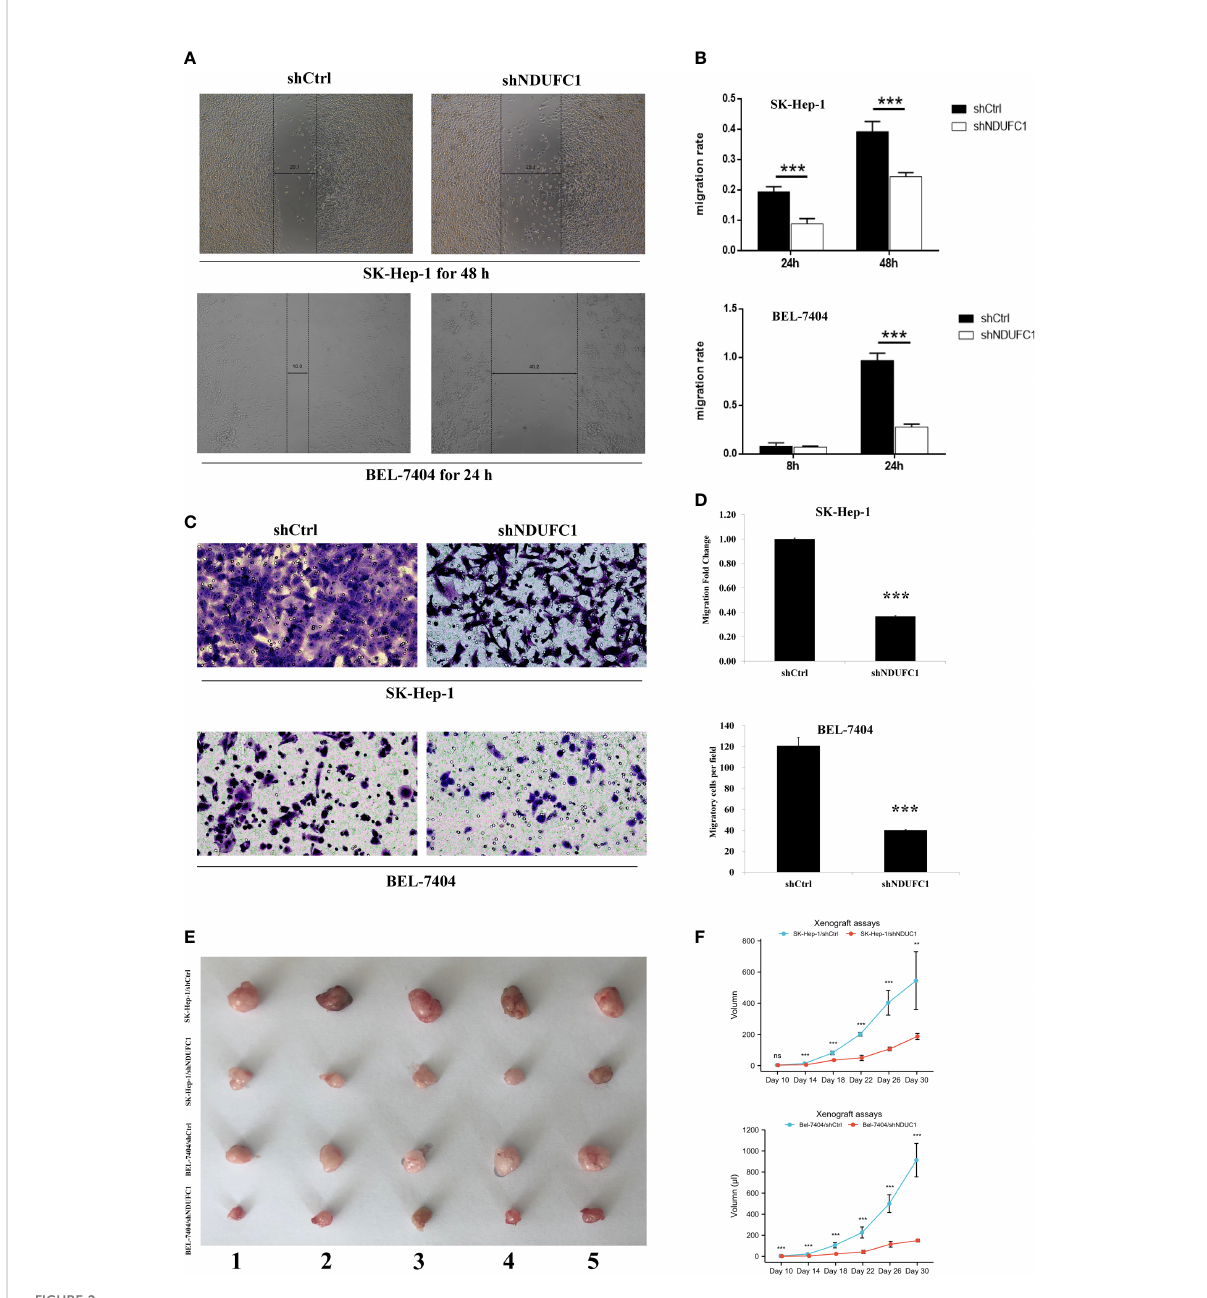
FIGURE 2 Silencing of NDUFC1 reduced migration and invasion in BEL-7404 and SK-HEP-1 cells. (A, B) Wound-healing assay of HCC cells transinfected with Lv-shNDUFC1 or Lv-shCtrl. (C, D) Transwell assay of HCC cells transinfected with Lv-shNDUFC1 or Lv-shCtrl. **P < 0.01; ***P < 0.001. ns, none signi fi cance (E, F) : Xenograft assays tumor formation in nude mice. Five nude mice were enrolled in the study. The tumorigenesis of shNDUFC1 group was signi fi cantly slower in SK-Hep-1 and